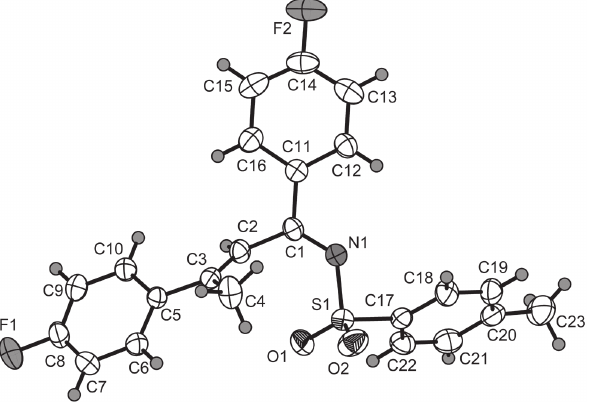
Table 1: Data collection and handling.